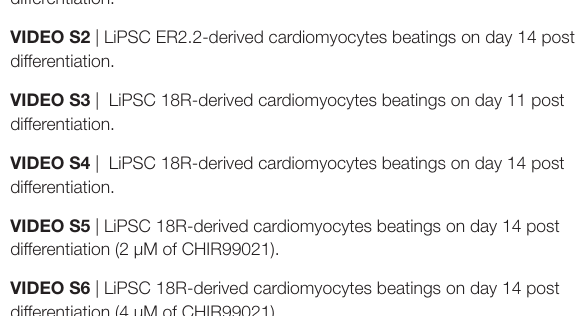
FigUre s1 | Differentiation of human-induced pluripotent stem cells (iPSCs) maintained in three commercially available culture systems. Human iPSCs were